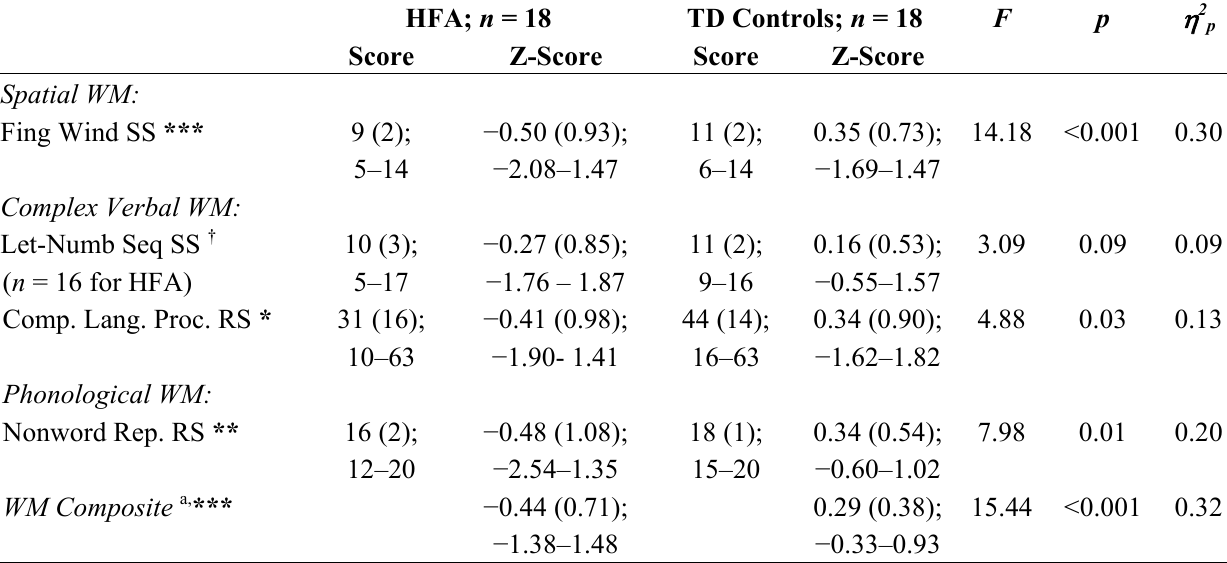
Table 1. Performance on working memory measures by